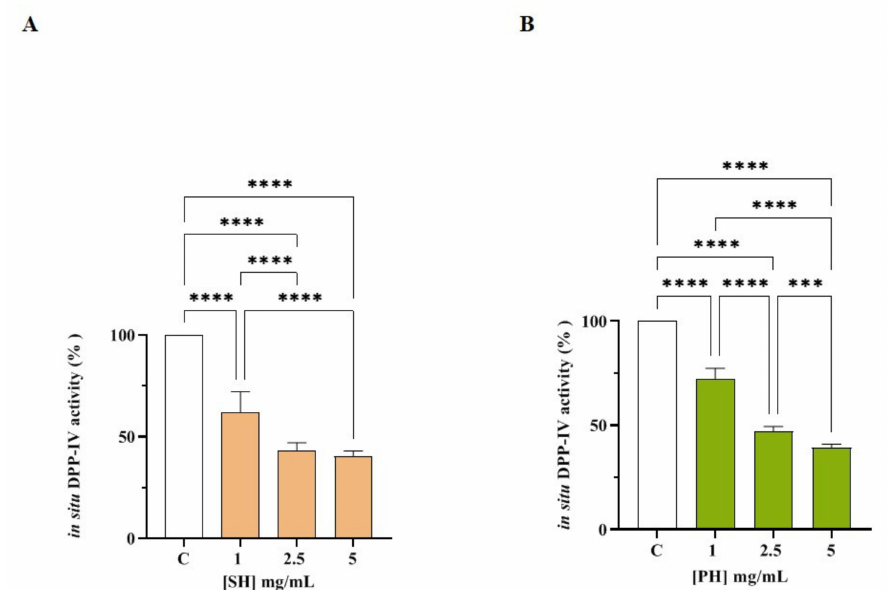
Figure 5. Effect of SH ( A ) and PH ( B ) on the cellular DPP-IV activity. The data points represent the averages ± SD of four independent experiments performed in triplicate. All data sets were analyzed by one-way ANOVA followed by Tukey’s post-hoc test; C: control sample (H 2 O), **** p < 0.0001, *** p < 0.001, non-significant (ns) is not